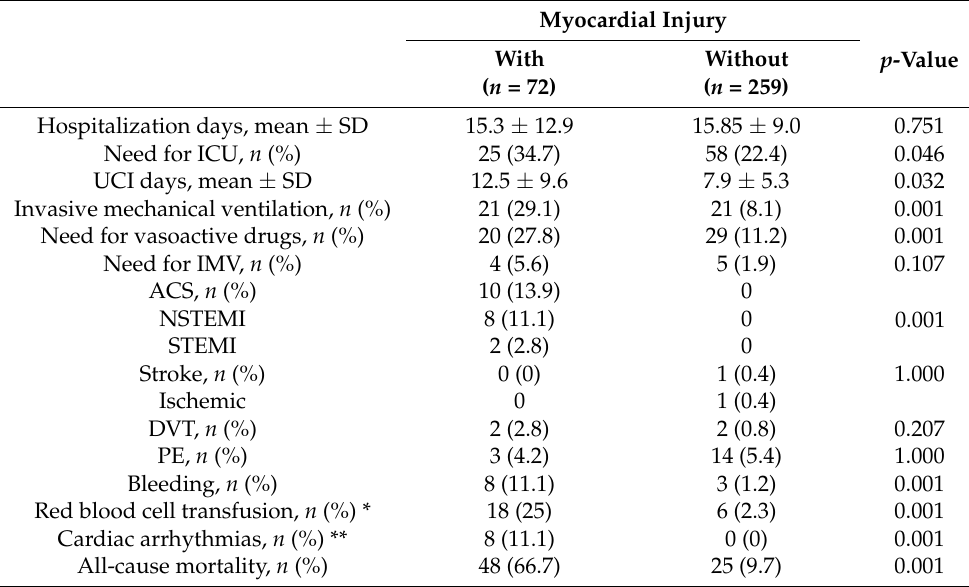
Figure 2. Incidence of mortality, ICU (intensive care unit) admission and mechanical ventilation in patients grouped according to their CAC (COVID-19-associated coagulopathy) score. Higher CAC scores were associated to higher ICU admission rates, higher invasive mechanical ventilation and higher mortality. Table 3. In-hospital days, ICU treatment and